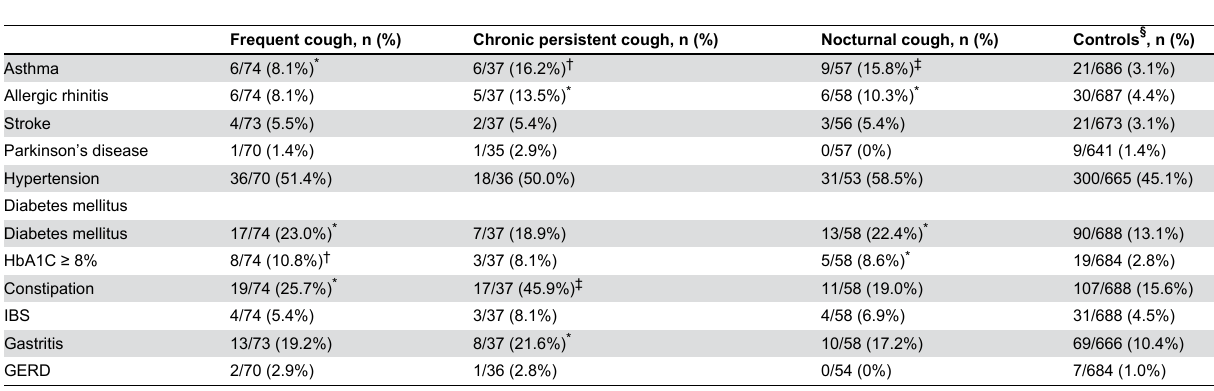
Table 2. Frequency of comorbid conditions in each type of